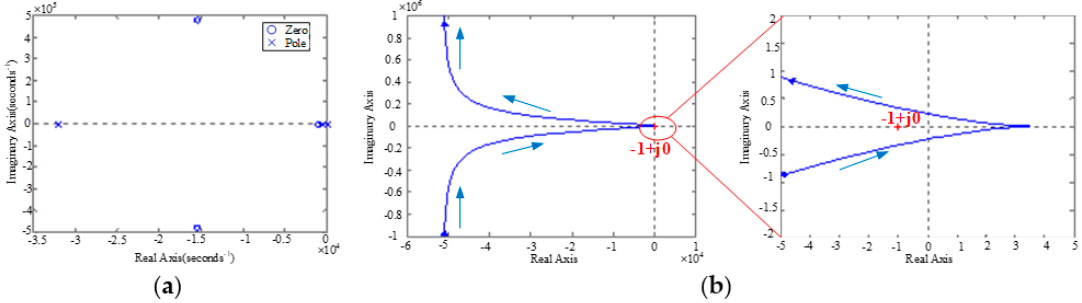
Figure 14. Pole-zero plot and Nyquist curve of Z g / Z ’ ou . ( a ) Pole-zero plot; ( b ) Nyquist curve, respectively.